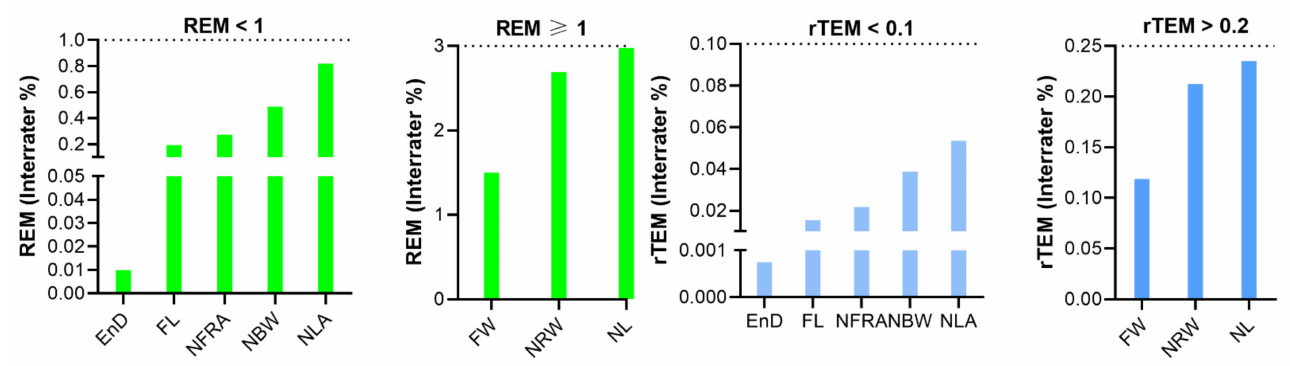
Figure 7. Inter-assessor relative error measurement (REM) and relative technical error of measurement (rTEM) of classic nasal measurements on three-dimensional